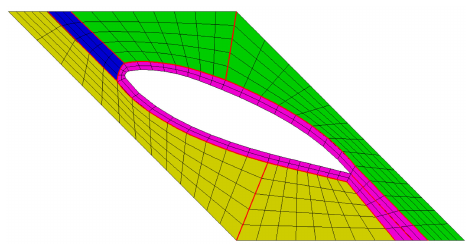
Figure 3. Grid topology around rotor blade sections.